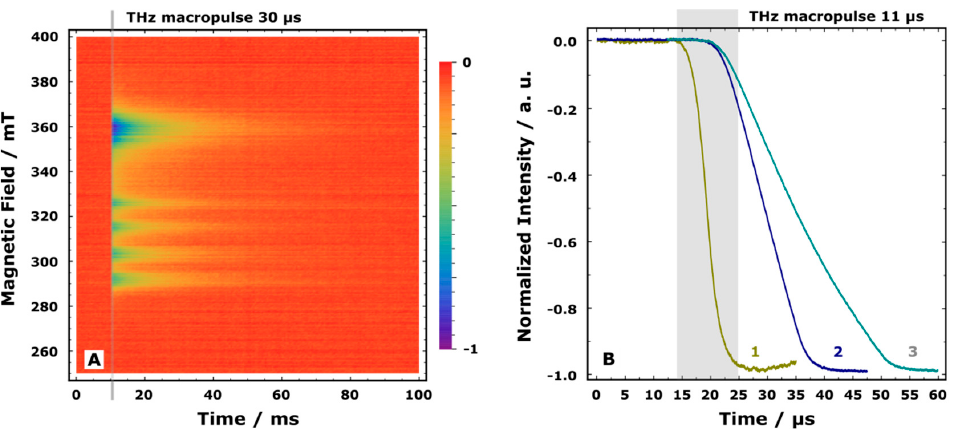
Figure 7. ( A ) Normalized time-resolved electron paramagnetic resonance (TR EPR) spectrum of I measured at 7 K using THz macropulses of 30 µ s length and 76.7 cm − 1 wavenumber. Microwave (MW) frequency is 9.79 GHz, MW power is 2 µ W, repetition rate of THz macropulses is 5 Hz. ( B ) The initial parts of normalized TR EPR kinetics of I at 360 mT obtained using di ff erent length of THz macropulses: (1) 11 µ s, (2) 20 µ s, (3) 30 µ s. A strong negative signal is induced by THz radiation, its build-up time reflects the macropulse length. A gray rectangle schematically shows the time range of the negative signal formation for the shortest macropulse used. Experimental parameters are the same as in